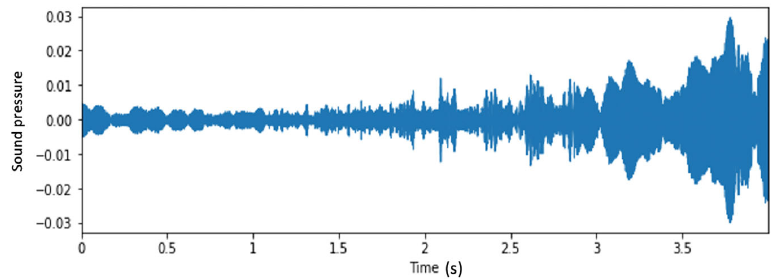
Figure 5. Concrete pouring sound data at a construction site: sound waveform.